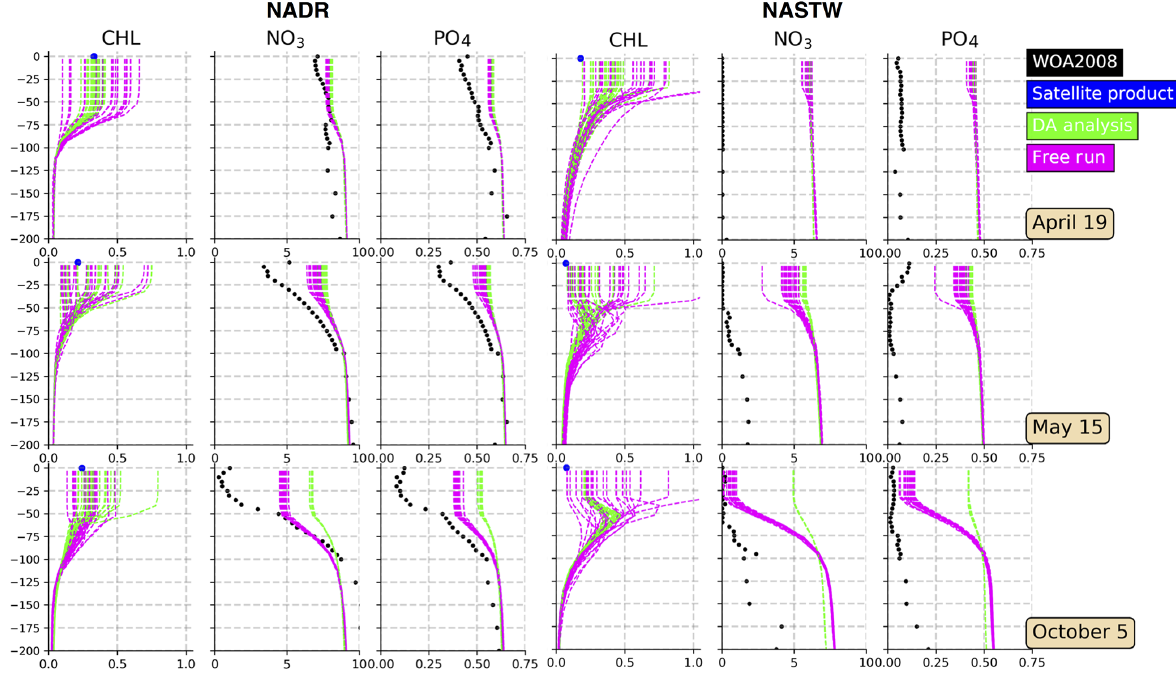
Figure 6. Vertical profiles (0–200m) of Chl a (mgChlm − 3 ), nitrate (mmolNm − 3 ), and phosphate (mmolPm − 3 ) for provinces NADR (left panels; at 50 ◦ N, 15 ◦ W) and NASTW (right panels; at 35 ◦ N, 60 ◦ W) for 19 April, 15 May, and 5 October 2005. The 24-member free run (in magenta) and analysis (in green) ensembles are represented. Black dots correspond to monthly mean nitrate and phosphate concentrations extracted from the WOA2018 database. Blue dots correspond to daily mean surface Chl a obtained from the Global Ocean Satellite